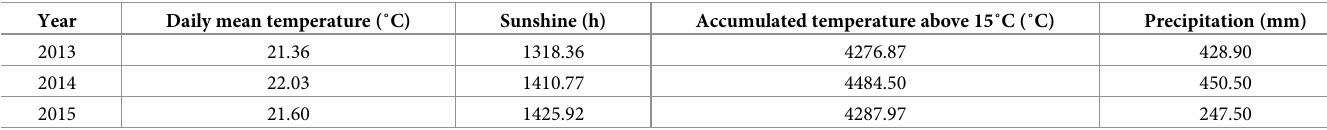
Table 1. The mean daily temperatures, cumulative hours of sunshine, and annual accumulated temperatures above 15˚C from April 1 st to October 31 st . Year Daily mean temperature (˚C) Sunshine (h) Accumulated temperature above 15˚C (˚C) Precipitation